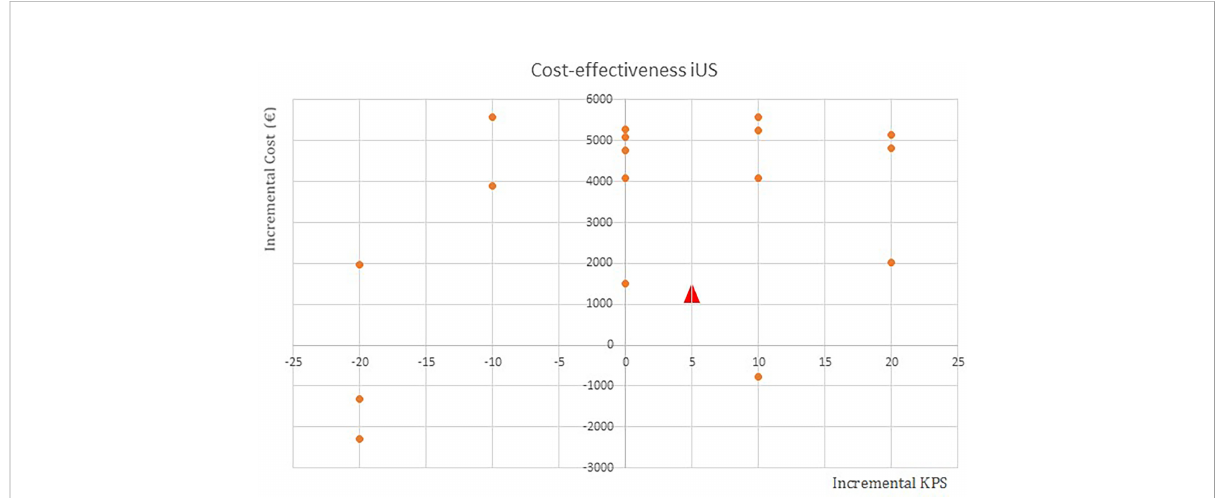
FIGURE 2 Cost-effectiveness plane of intraoperative ultrasound (iUS) compared to the intraoperative magnetic resonance imaging device. Each blue point represents a replicated case. The red triangle is the average of all the cases. X-axis, Effectiveness measure (KPS); Y-axis, Cost in